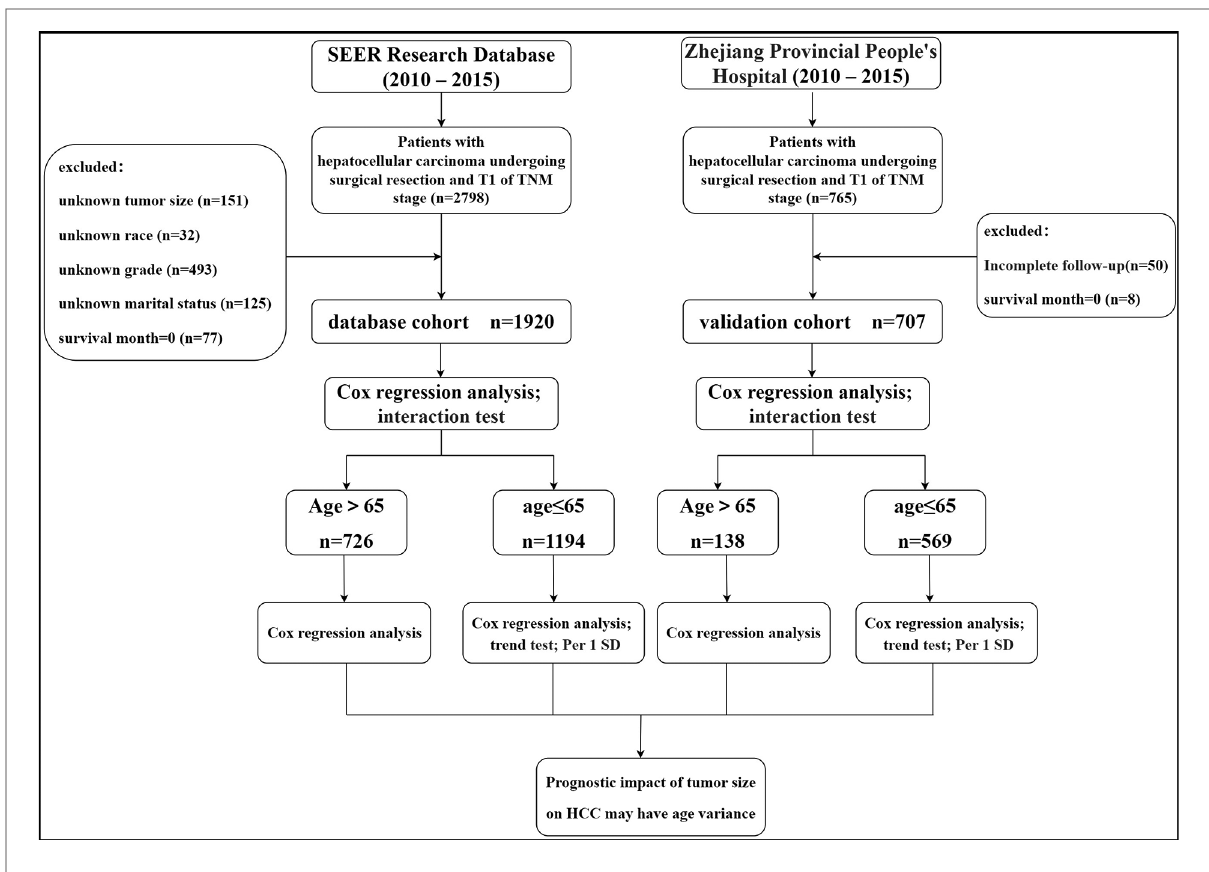
FIGURE 1 Flow chart of patient inclusion and main analysis.